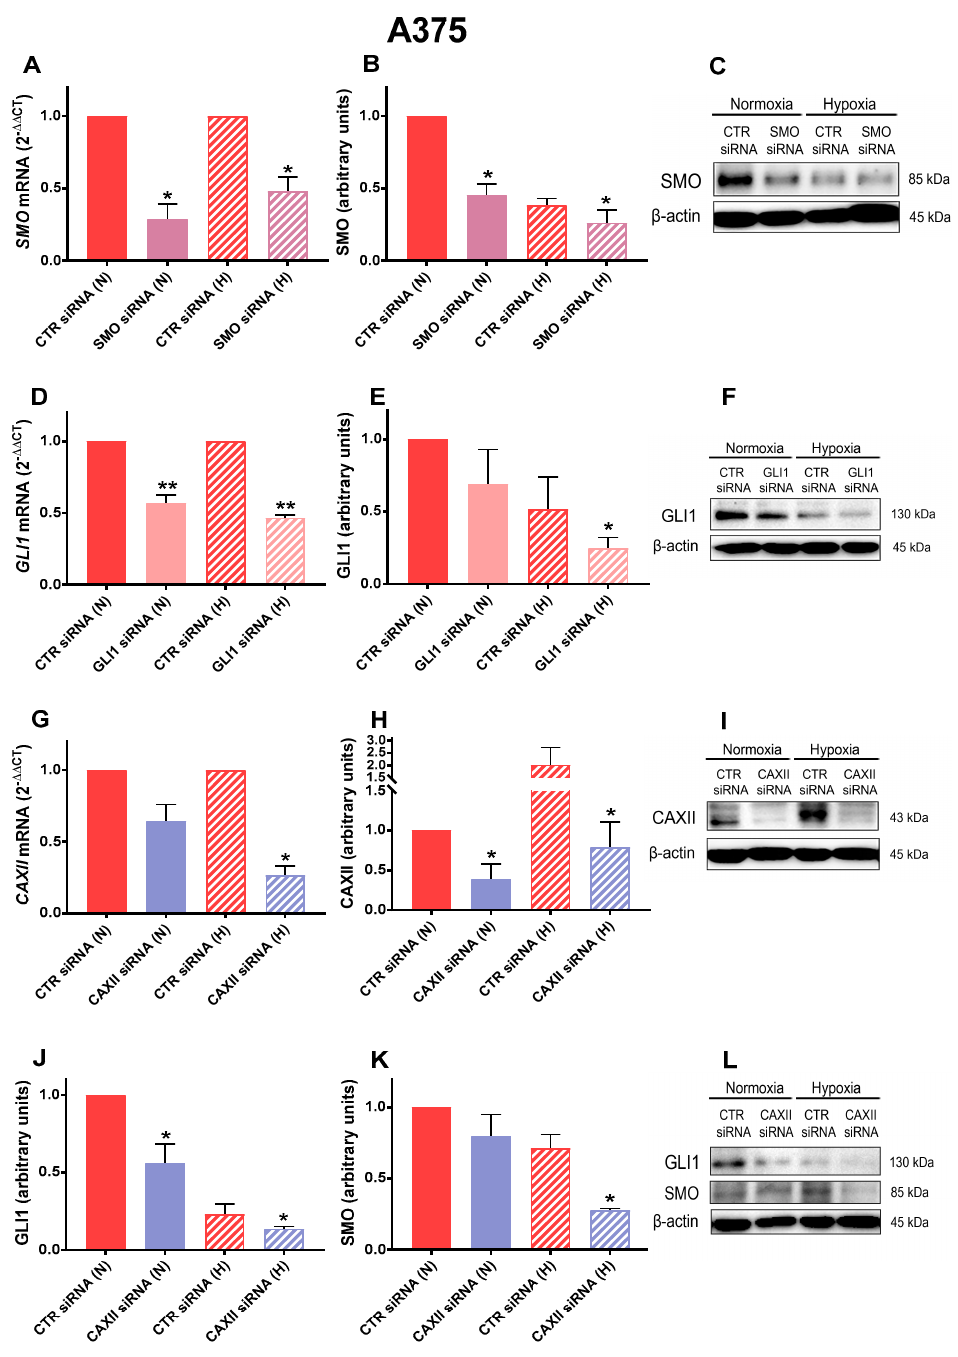
Figure 3. SMO, GLI1, and CAXII transient knockdown in A375. SMO ( A – C ), GLI1 ( D – F ), CAXII ( G – I ), and GLI1 and SMO in CAXII-siRNA-treated A375 ( J – L ) mRNA as determined by RT-qPCR and western blot analysis for A375 silenced by siRNA under normoxic (N) or hypoxic (H) conditions. β -actin was used as loading control for western blot, and L32 was used as housekeeping gene for RT-qPCR. Blots are representative of three independent experiments. Means ± SEM are presented. (n = 3; * p ≤ 0.05 and ** p ≤ 0.01 indicate statistically significant differences).